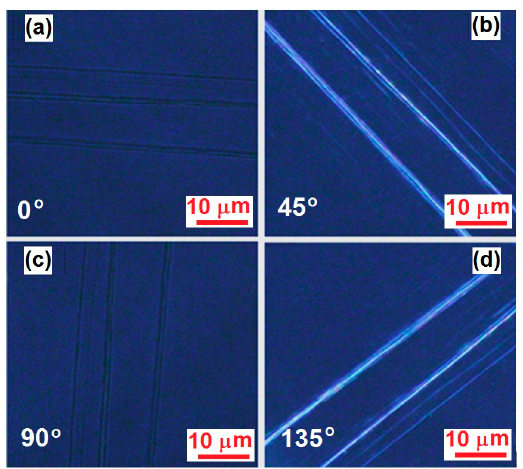
Figure 4. Polarization optical microscopic images measured on the PFB fibers with the grating lines orientated at ( a ) 0 ◦ ; ( b ) 45 ◦ ; ( c ) 90 ◦ ; and ( d ) 135 ◦ with respect to one of the two orthogonally-arranged polarizers.